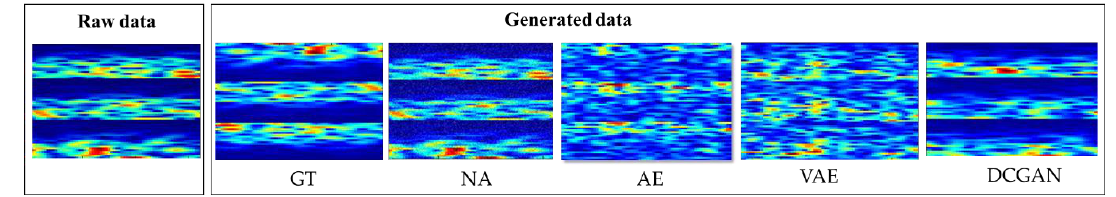
Figure 13. The post hoc data after data augmentation using different methods.